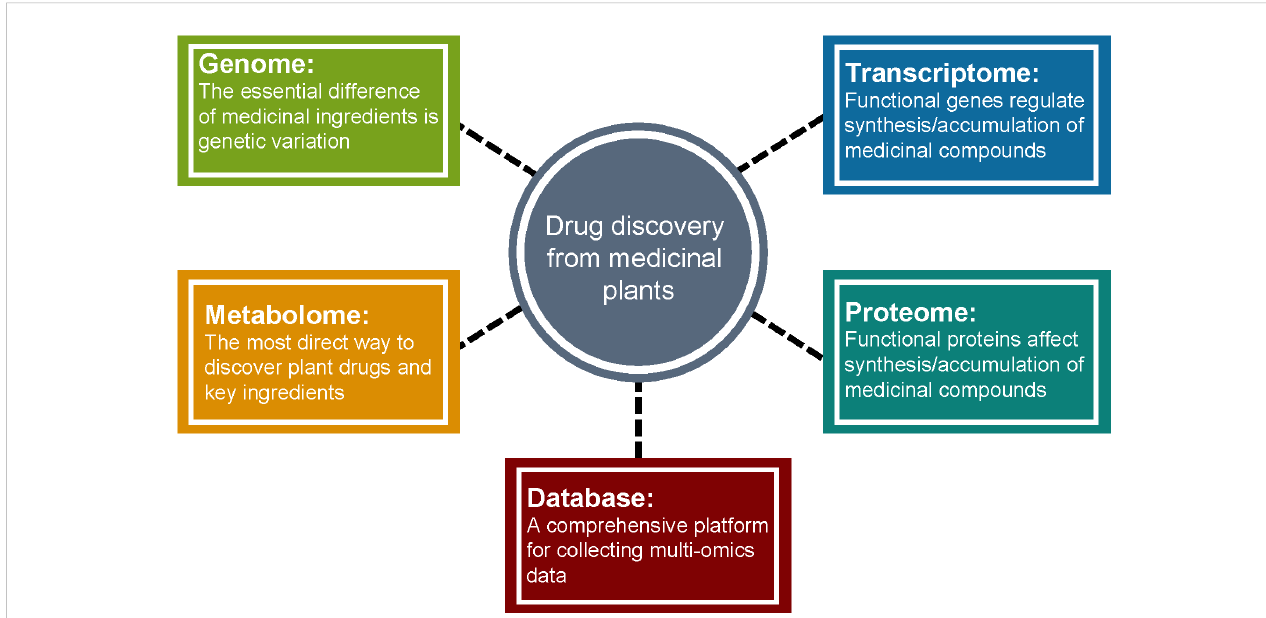
FIGURE 6 Medicinal plant multi-omics research to facilitate drug